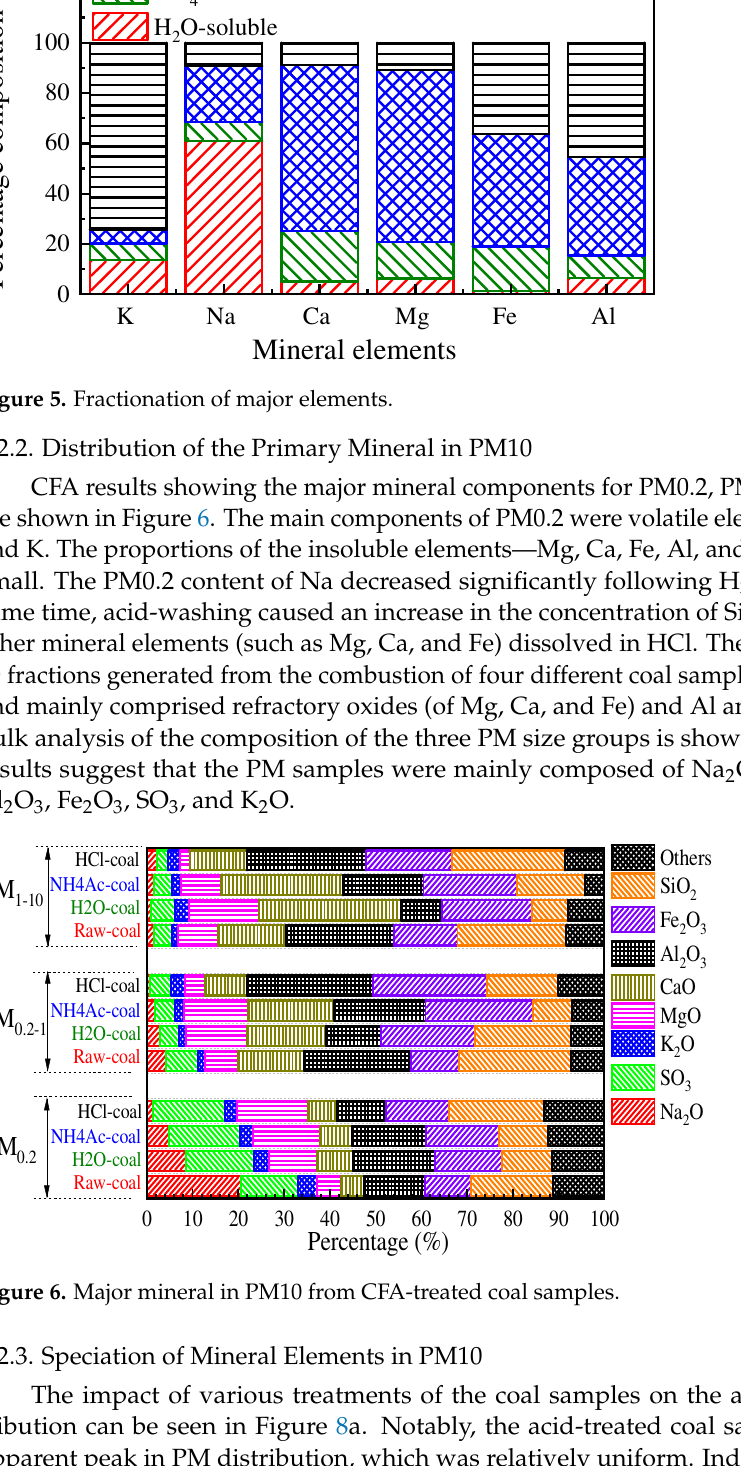
Figure 7. Composition of various size fractions of coal ash generated from CFA-treated coal sam- ples. Volatile denotes Na, K, and S; Non-volatile denotes Mg, Ca, and Fe.